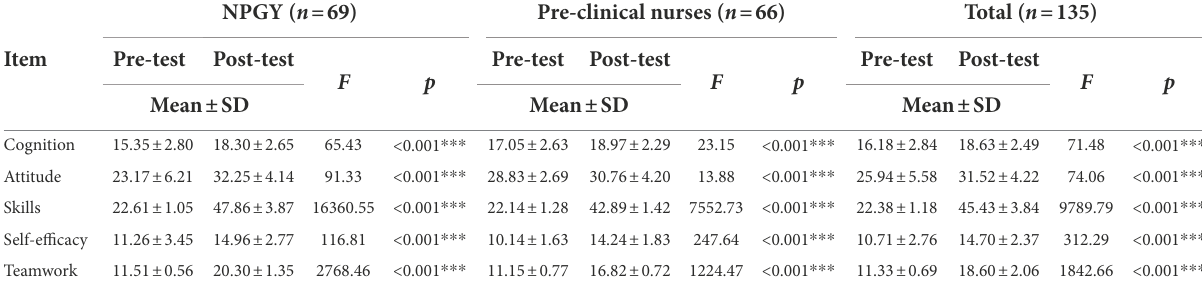
TABLE 2 Analysis of the difference between the pre-test and the post-test of the high-realistic situation simulation of dyspnea teaching program ( N = 135). NPGY ( n = Item